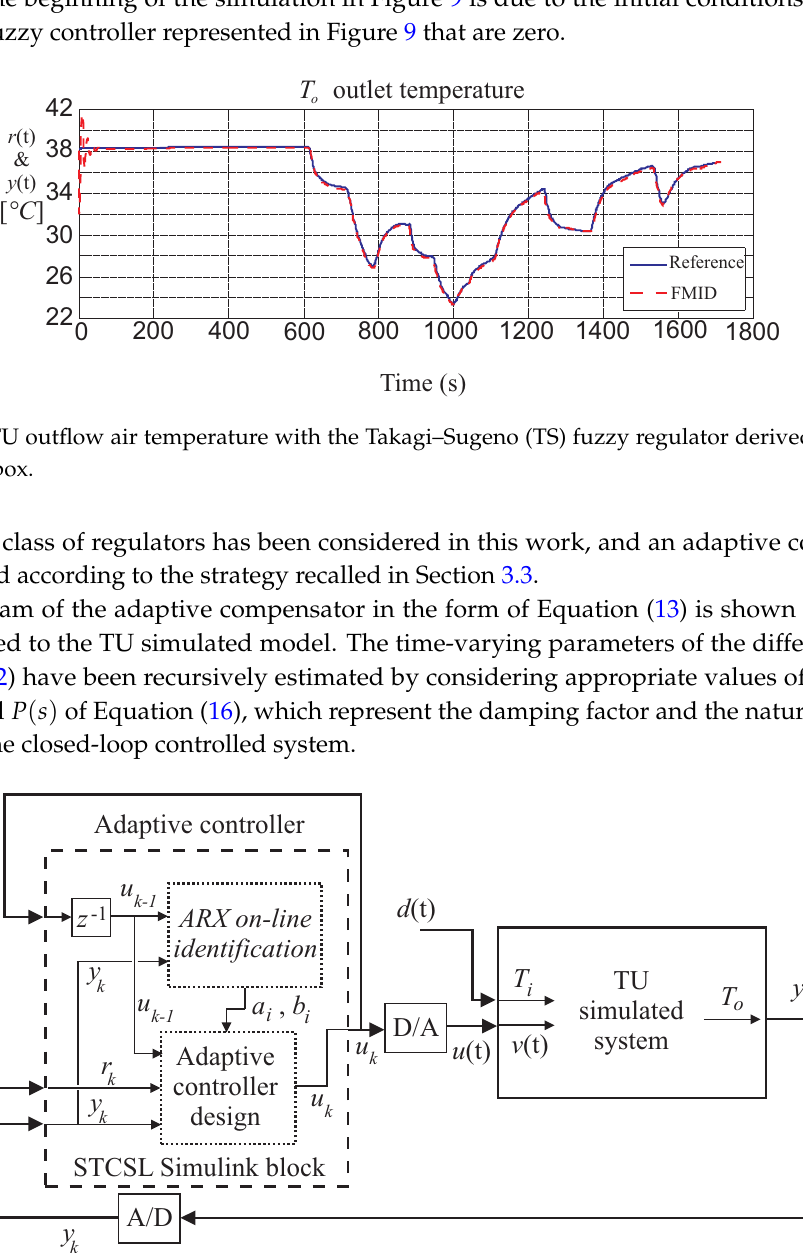
Figure 10. Diagram of the TU module controlled by the adaptive